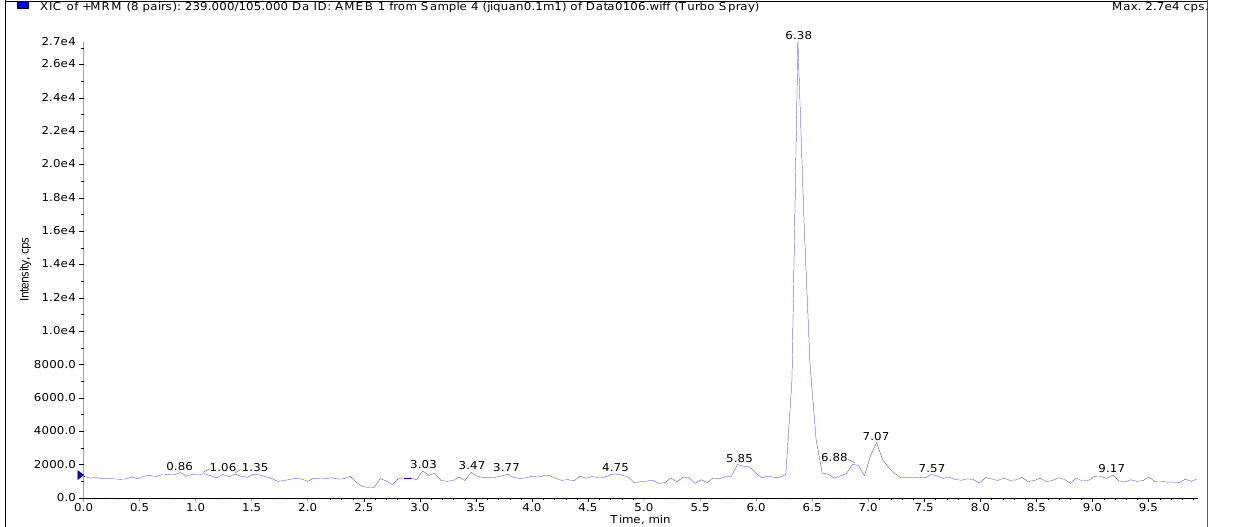
Figure 5. Total ion chromatograms and extracted ion chromatograms of blank whole egg samples with standard addition. (( a ) Total ion chromatogram; ( b ) extracted ion chromatogram of a sample spiked with 1 µg/kg LMS; ( c ) extracted ion chromatogram of a sample spiked with 6 µg/kg MBZ; ( d ) extracted ion chromatogram of a sample spiked with 6 µg/kg HMBZ; ( e ) extracted ion chromatogram of a sample spiked with 6 µg/kg AMBZ.).